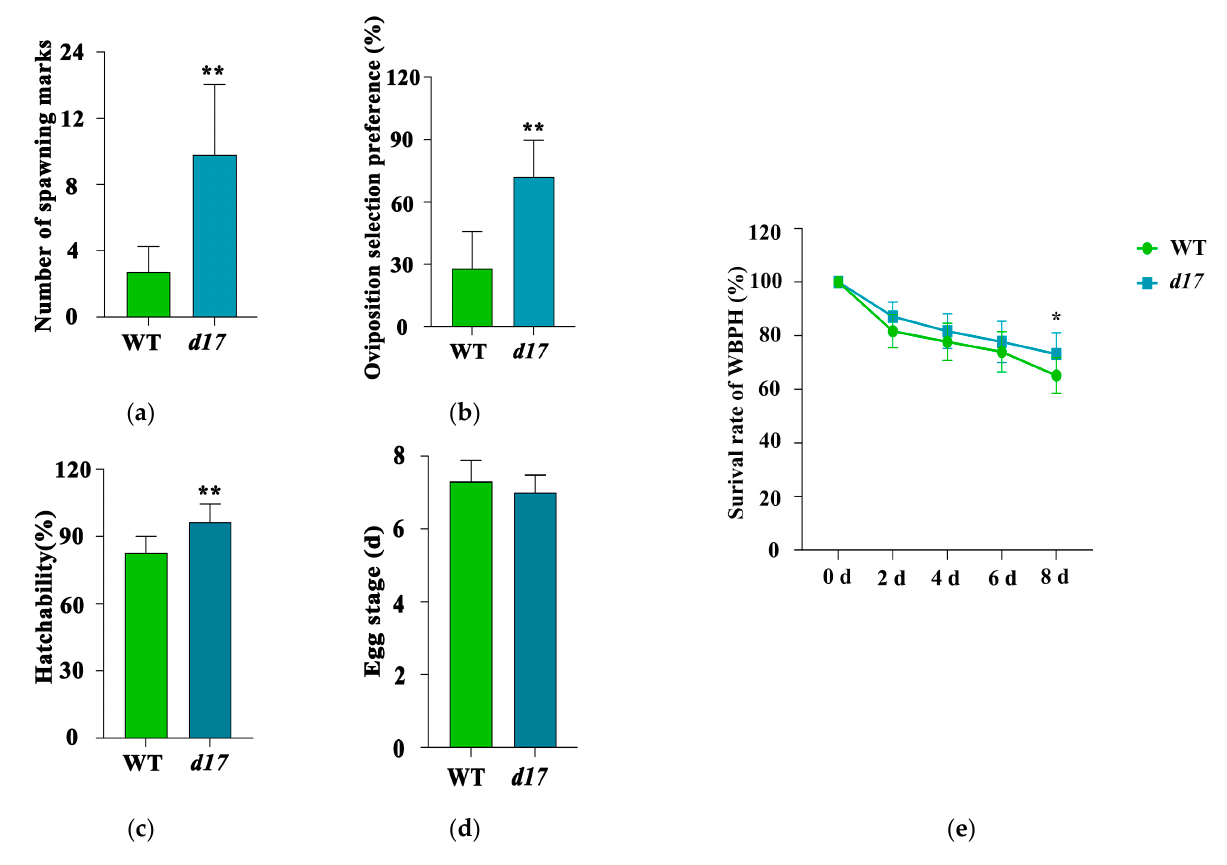
Figure 4. ( a , b ) Di ff erence in WBPH oviposition selection preference between the WT and d17 plants. Average (±SD) values from ten biological replicates. Signi fi cant di ff erences were calculated using the chi-squared test for dependent samples, ** p < 0.01. ( c ) Di ff erence in WBPH hatching rates between the WT and d17 plants. Average (±SD) values from ten biological replicates. Signi fi cant differences were determined using Student’s t-test for dependent samples, ** p < 0.01. ( d ) Di ff erence in WBPH egg stage between the WT and d17 plants. Average (±SD) values were 425 eggs from the WT plants and 386 eggs from the d17 plants. Signi fi cant di ff erences were determined using Student’s t-test for dependent samples. ( e ) Di ff erence in WBPH survival rate between the WT and d17 plants. Average (±SD) values from ten biological replicates. Signi fi cant di ff erences were determined using Student’s t-test for dependent samples, * p < 0.05.